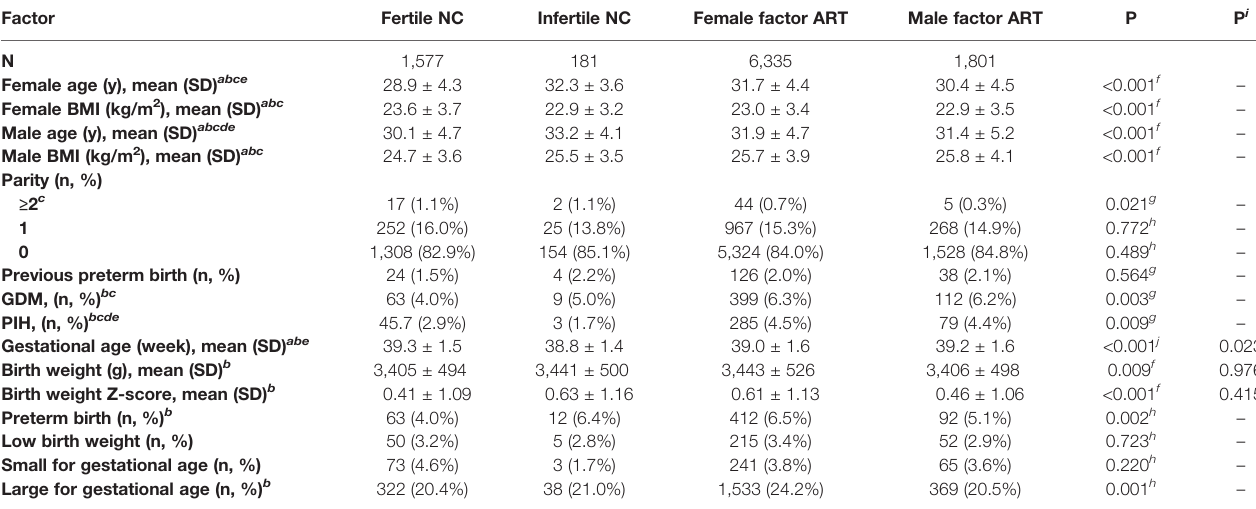
TABLE 1 | Baseline characteristics and birth outcomes.